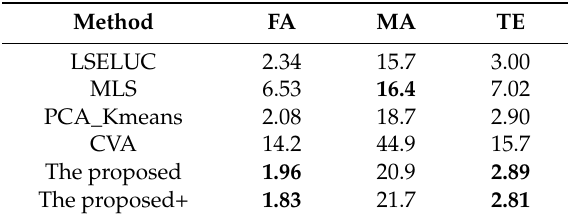
Table 5. Comparison between other methods and the proposed approach for the landslide of Hong Kong